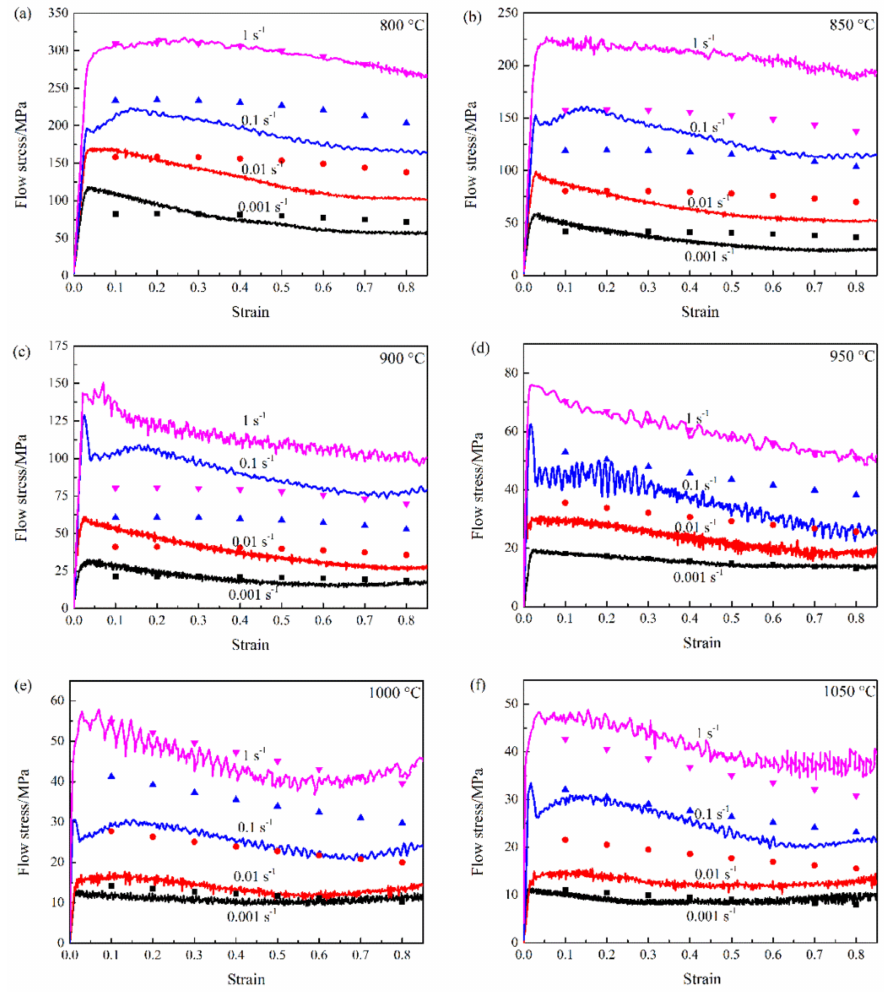
Figure 7. Comparison between the experimental (solid lines) and predicted (dots) flow stress from the modified Johnson-Cook model at the temperature of ( a ) 800 ◦ C; ( b ) 850 ◦ C; ( c ) 900 ◦ C; ( d ) 950 ◦ C; ( e ) 1000 ◦ C; ( f ) 1050 ◦